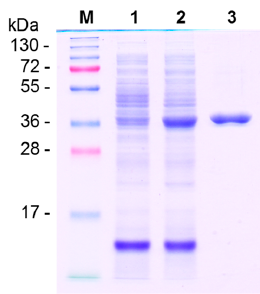
Figure 3. Expression and purification of recombinant PfOMT3. M, size marker; 1, crude extract before isopropyl β -D-1-thiogalactopyranoside (IPTG)-induction; 2, crude extract after IPTG-induction; 3, Ni 2+ -affinity purified PfOMT3.